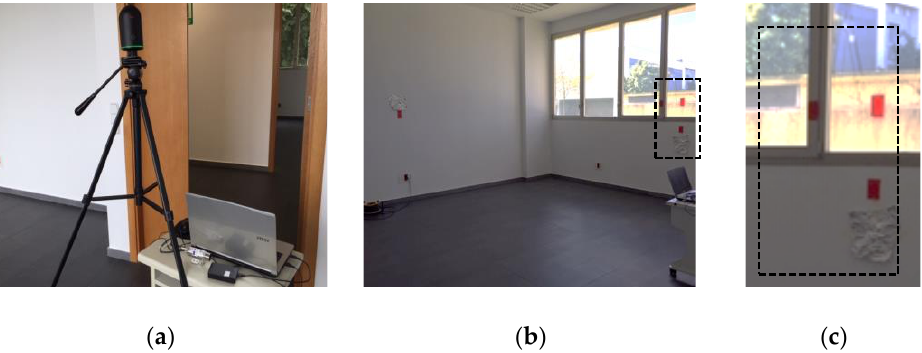
Figure 3. ( a ) 3D geometric and thermal scanner; ( b ) Perspective of one of the rooms of the case study; ( c ) Detail of the objectives for reading the parameters T ref and ε .